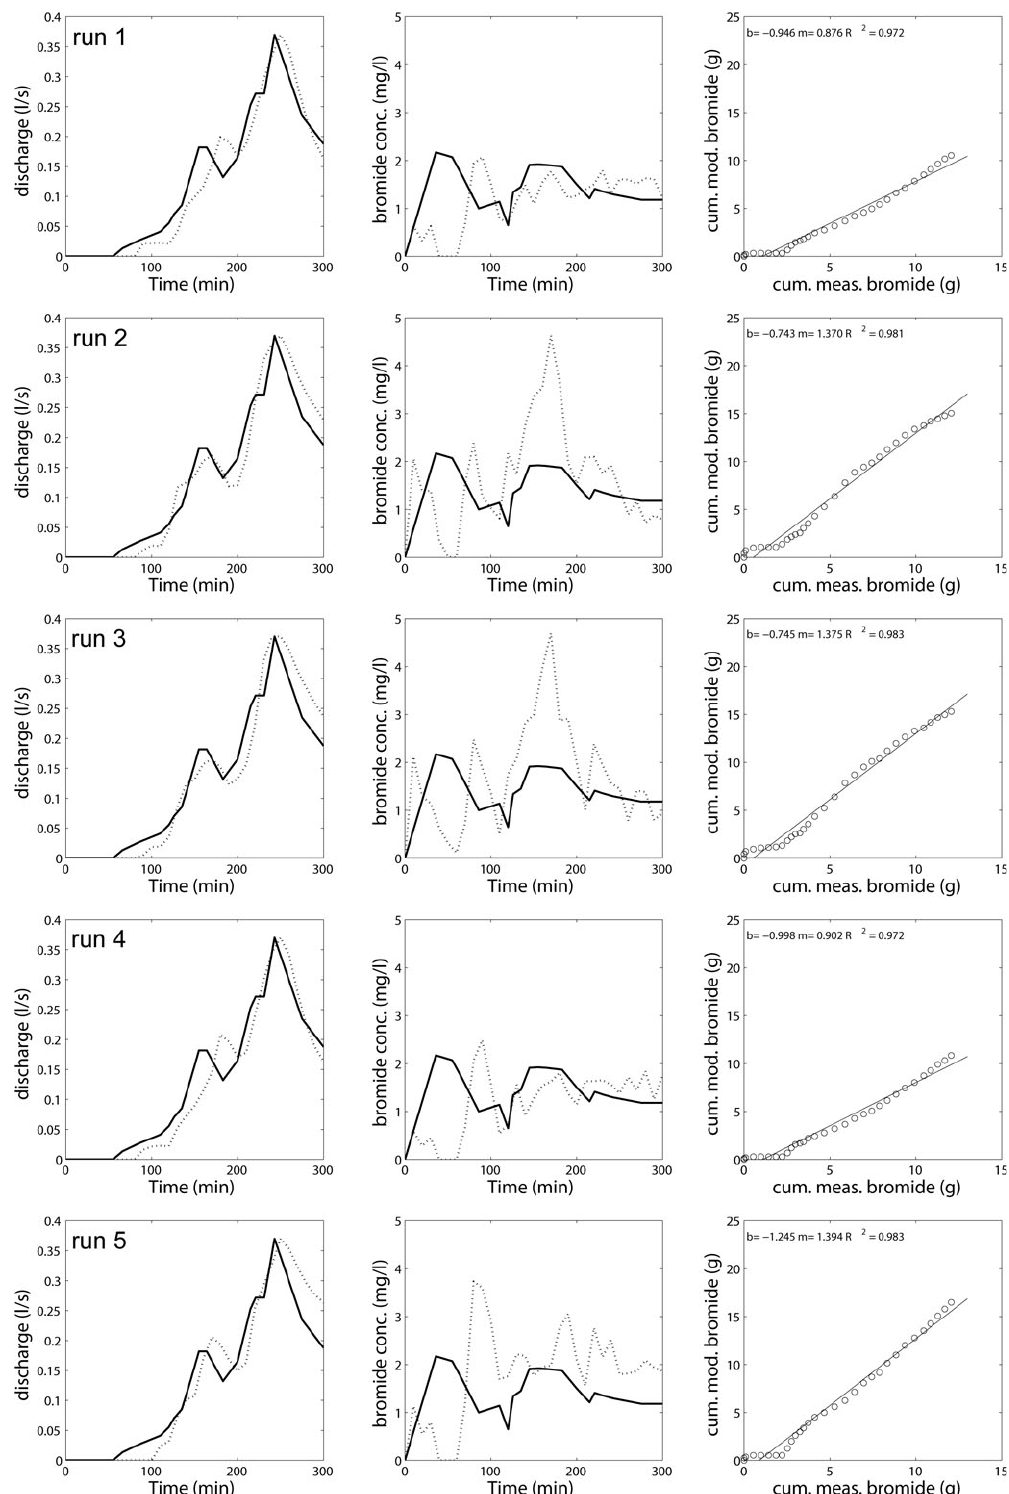
Fig. 3. The left column presents the observed discharge (solid line) and the modelled discharge (dotted line), the centre column presents the observed (solid line) and modelled (dotted line) bromide concentrations in the tile drain, while the right column presents the cumulated modelled bromide outflow versus the measured one and a linear regression line between them (b denotes the intersect and m the slope of the regression). The runs 1 to 5 are shown